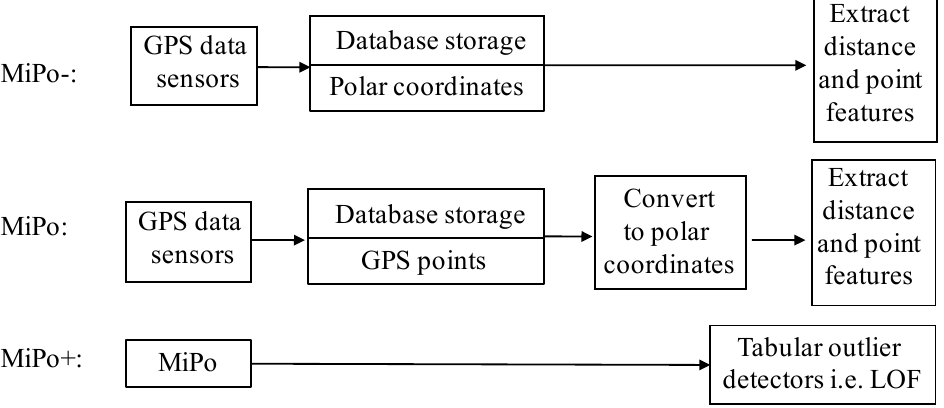
Figure 12. The illustration of MiPo-, MiPo, and MiPo+. As shown in Table 4, MiPo- required approximately 0.79 s to extract features for 10,000 of trajectories with lengths of 90, averaging 1 µ s for each trajectory. MiPo required an average of 2.7 ms to extract features for each trajectory. This demonstrated MiPo’s